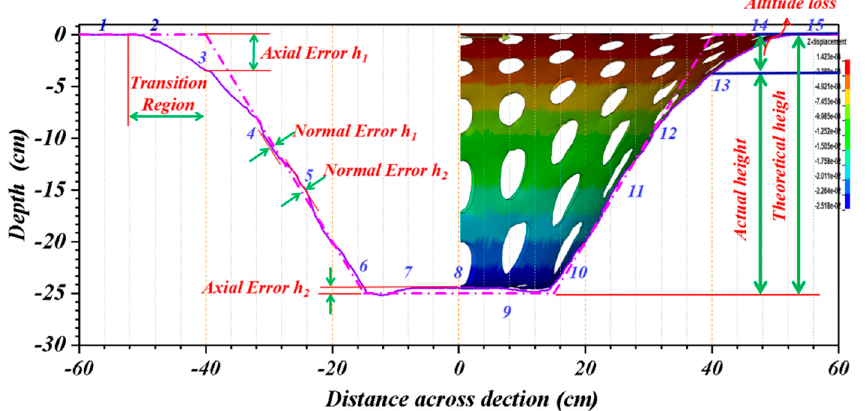
Figure 8. Geometric error evaluation diagram of perforated titanium sheet cone counterparts in vertical Z plane.